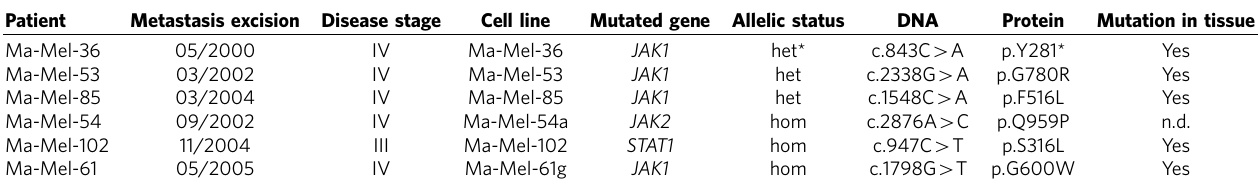
Table 1 | Acquired mutations in genes of the IFN g signalling